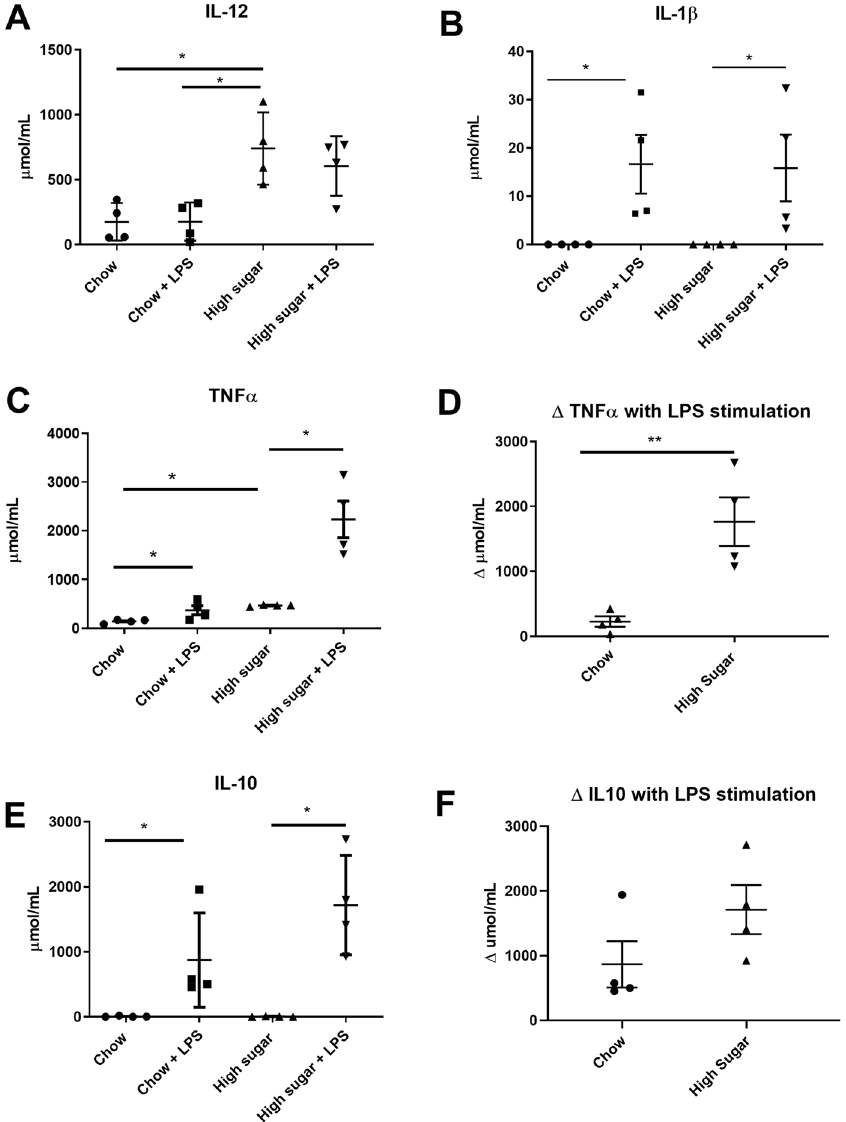
Figure 5. Cytokine secretion from bone-marrow derived monocytes (BMDM). BMDM generated from chow and high sugar fed mice were incubated ± lipopolysaccharide for 24 hours. BMDM from high sugar fed mice had increased basal secretion of IL-12p70 ( A ) and TNF α ( C ). BMDM generated from both chow and high-sugar fed mice responded to LPS with increased secretion of IL-1 β ( B ), TNF α ( C ), and IL-10 ( E ). Δ TNF α secretion in response to LPS stimulation was higher in BMDM from high sugar fed mice compared with Δ TNF α secretion in BMDM from chow fed mice. ( D ). There was no difference in Δ IL-10 secretion to LPS stimulation between the two groups. Data is shown as mean ± SEM. Chow: n = 4; HS: n = 4. ** p < 0.01; * p <